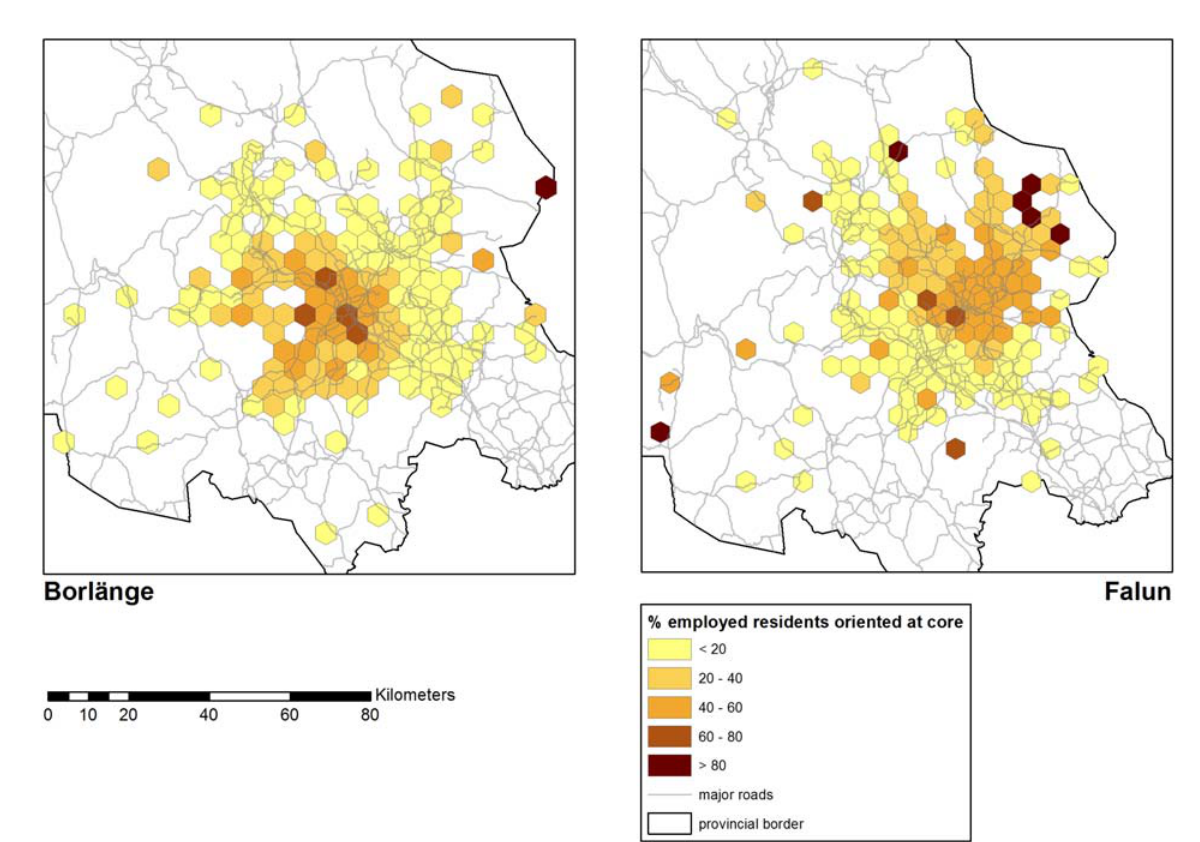
Figure 8. Commuting fields of Borlänge and Falun.